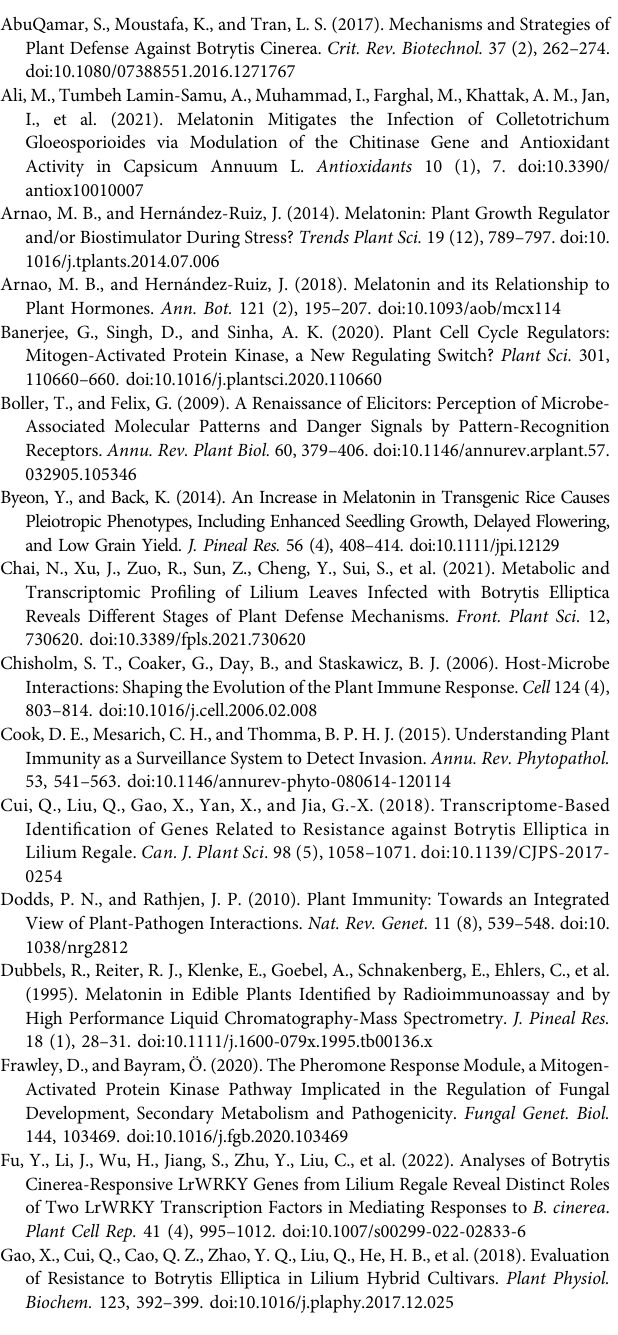
Supplementary Table S4 | Statistics of DEGs for GO enrichment analysis in different comparison group. Supplementary Table S5 | Statistics of DEGS for KEGG pathway enrichment analysis in different comparison group. Supplementary Table S6 | The sequence information of primers for